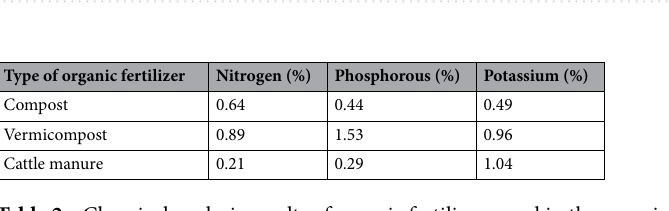
Table 2. Chemical analysis results of organic fertilizers used in the experiment.